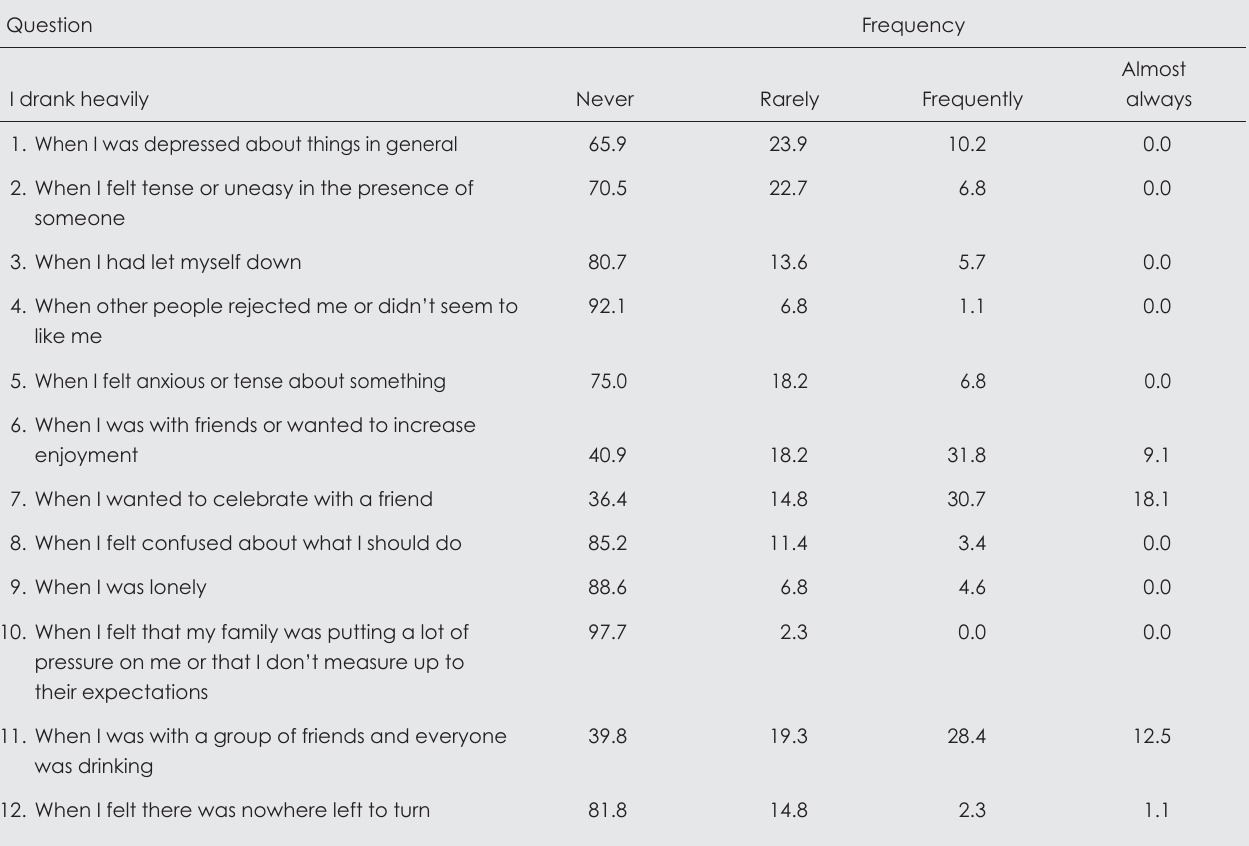
Table III. Results of the Inventory of Drug-taking Situations in percentages ( N =